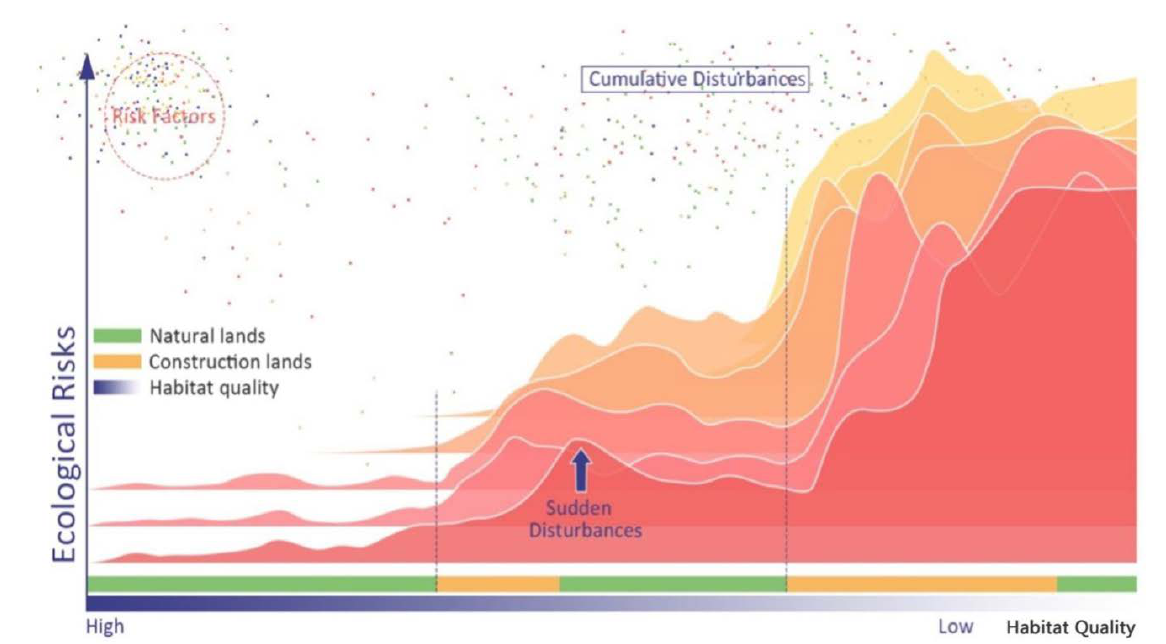
Figure 2. Conceptual framework for the relationship between habitat quality and ecological